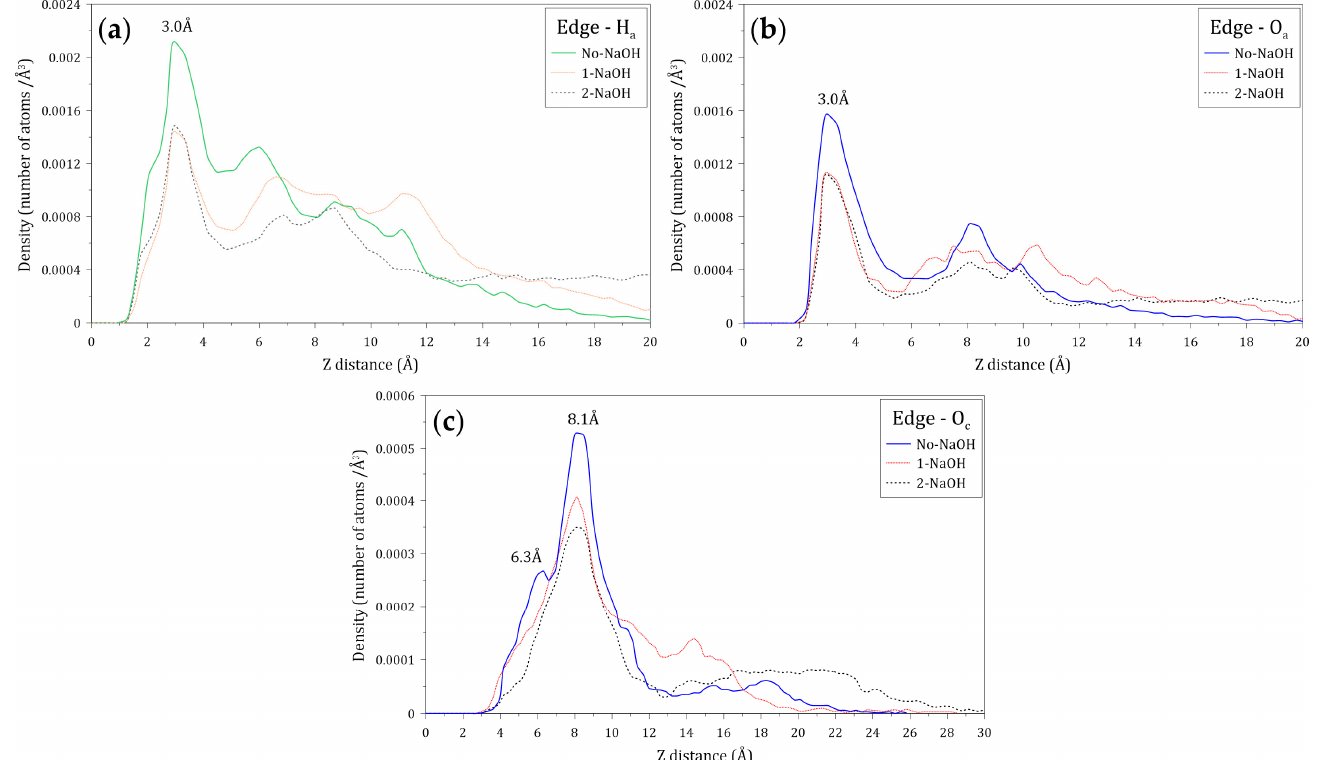
Figure 13. Atomic density profile of ( a ) hydrogen atoms of amide groups, ( b ) oxygen atoms of amide groups, and ( c ) oxygen atoms of carboxylate groups of the flocculant on the molybdenite edge sur- face.